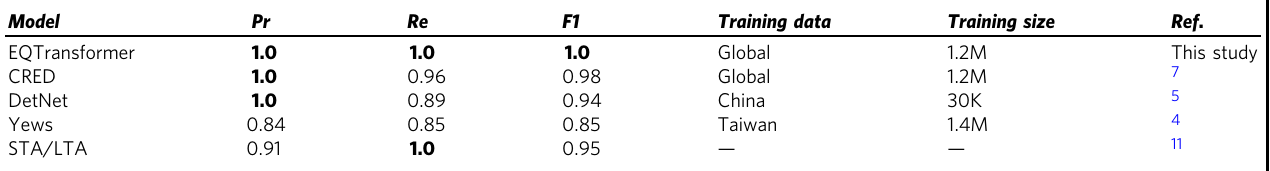
Table 1 Detection performance.